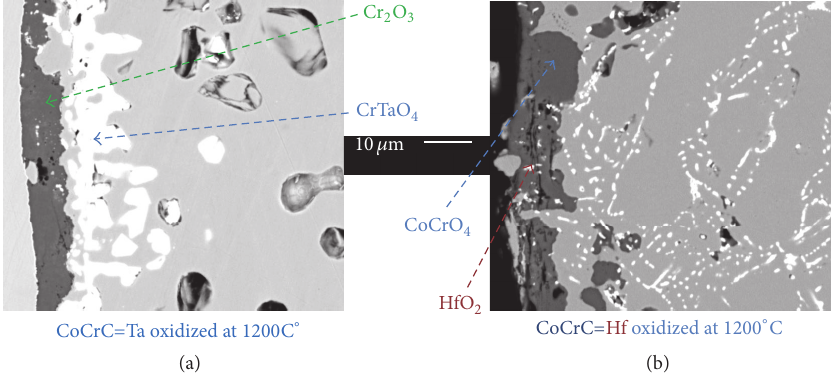
Figure 12: Surface and subsurface states of the “CoCrC=Ta” alloy (a) and of the “CoCrC=Hf” alloy (b) after their oxidation in air at 1200 ∘